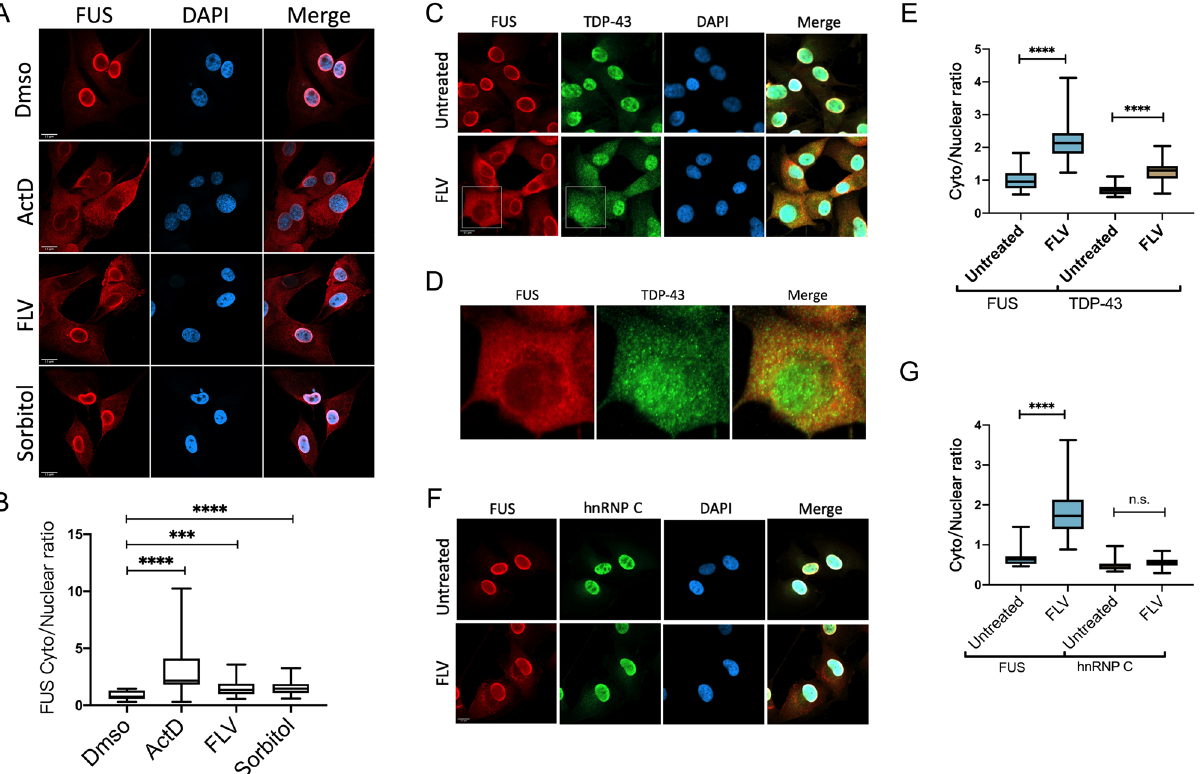
Figure 1. Transcriptional inhibition and hyperosmolarity induces FUS cytoplasmic translocation. ( A ) U87 cells were incubated with actinomycin D (ActD, 5 ug/ml), flavopiridol (FLV, 1 uM) or sorbitol (0.4 M) for 4 h, followed by paraformaldehyde fixation and FUS immunofluorescence (IF) using primary anti-FUS antibodies. Samples were washed, stained with secondary antibody, mounted and sealed for confocal imaging. ( B ) Cytoplasmic to nuclear FUS ratios were compared with the DMSO control. n = 24–33 cells were analyzed in each experimental condition. (*** p = 0.0003, **** p < 0.0001) Mann–Whitney U -test. ( C ) U87 cells were incubated with 1 uM flavo for 4 h followed by FUS and TDP-43 IF. ( D ) Magnified images of FUS and TDP-43 co-staining. ( E ) Cytoplasmic to nuclear ratios were quantified for each protein in ( C ). n = 11–17 cells were analyzed in